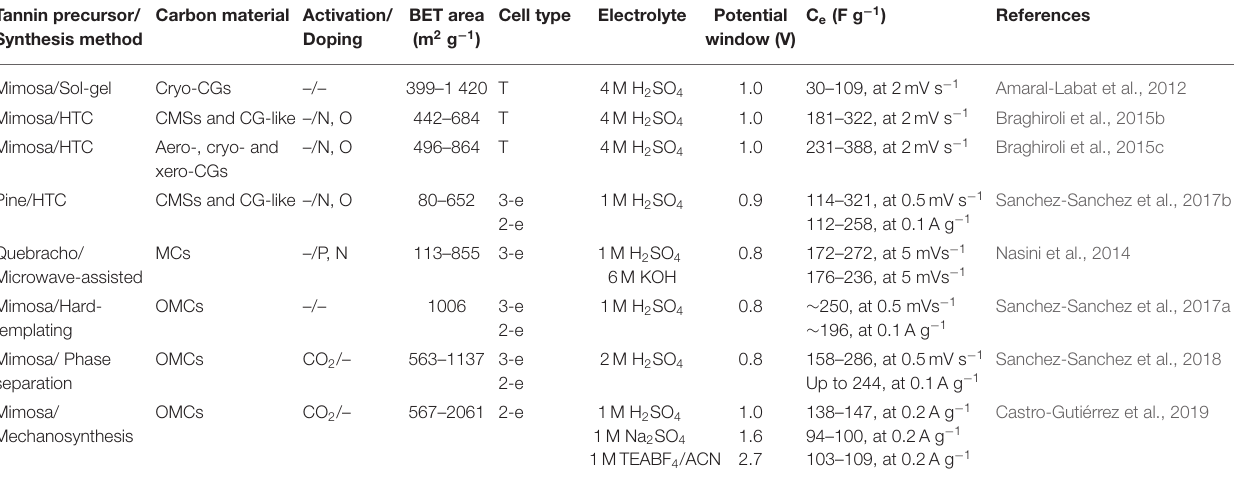
TABLE 3 | Summary of methods, properties and electrochemical performance of tannin-derived carbon materials. Tannin precursor/ Carbon material Activation/ Synthesis method